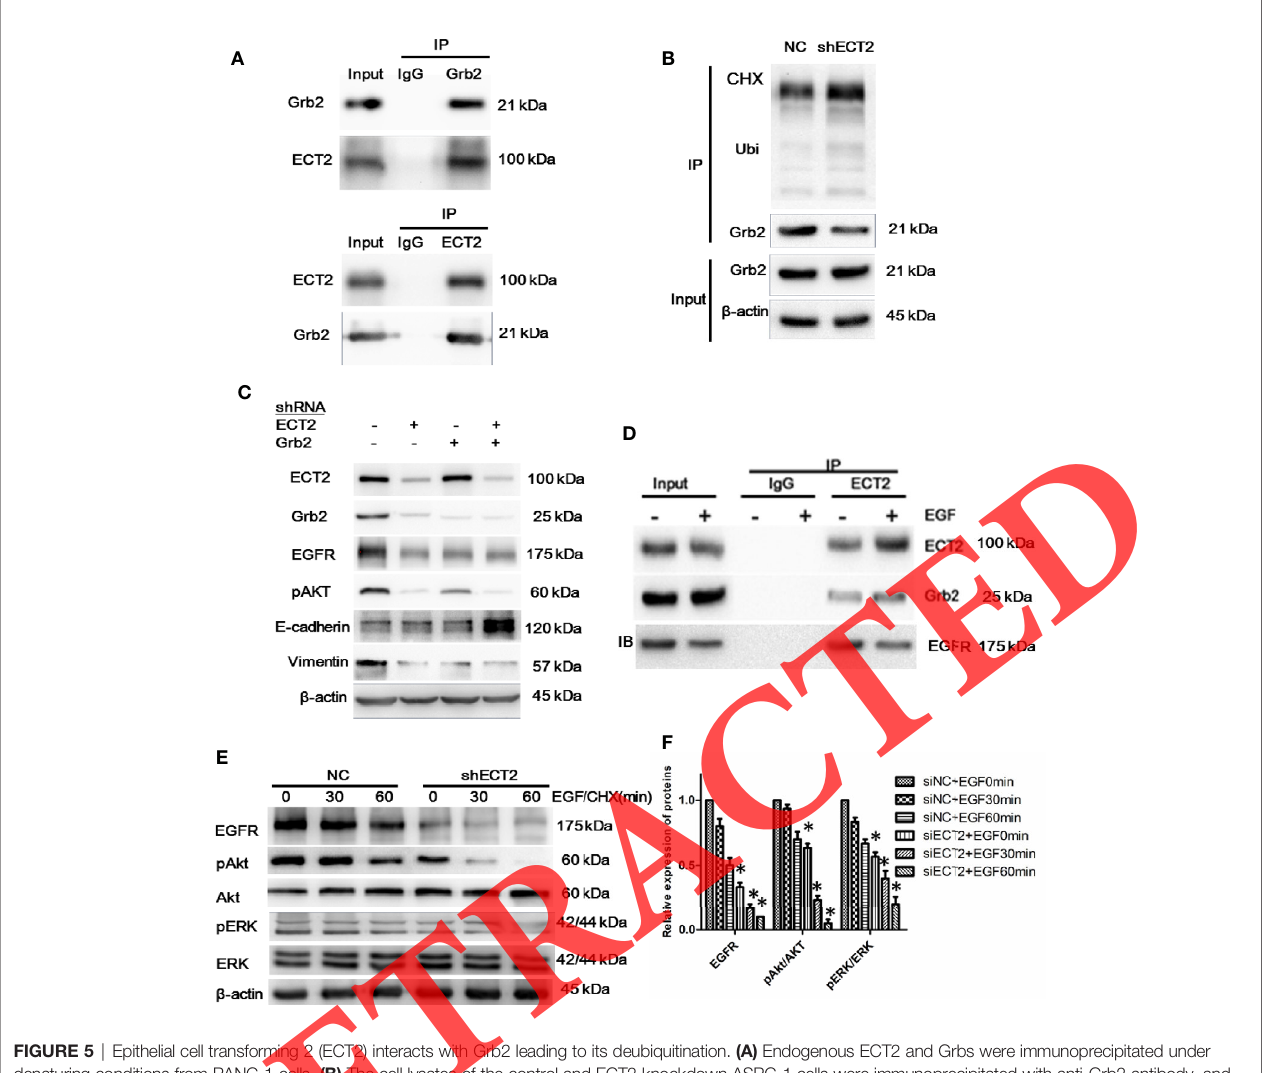
FIGURE 5 | Epithelial cell transforming 2 (ECT2) interacts with Grb2 leading to its deubiquitination. (A) Endogenous ECT2 and Grbs were immunoprecipitated under denaturing conditions from PANC-1 cells. (B) The cell lysates of the control and ECT2 knockdown ASPC-1 cells were immunoprecipitated with anti-Grb2 antibody, and the immunocomplexes were immunoblotted with anti-Grb2 and anti-ubiquitin antibodies in the presence of cycloheximide(CHX). (C) Molecules in stable PANC-1 cells with ECT2 or Grb2 knockdown were determined by the western blot. (D) The ASPC-1 cells were treated with EGF in the presence of cycloheximide (CHX). The cell lysates were then immunoprecipitated with anti-EGFR antibody, and the immunocomplexes were immunoblotted with anti-Grb2 and anti-ECT2 antibodies. (E, F) Knocking down ECT2 reduces EGFR and baseline phosphorylation levels of ERK and Akt and also decreases the level of maximal phosphorylation of ERK and Akt. *p <